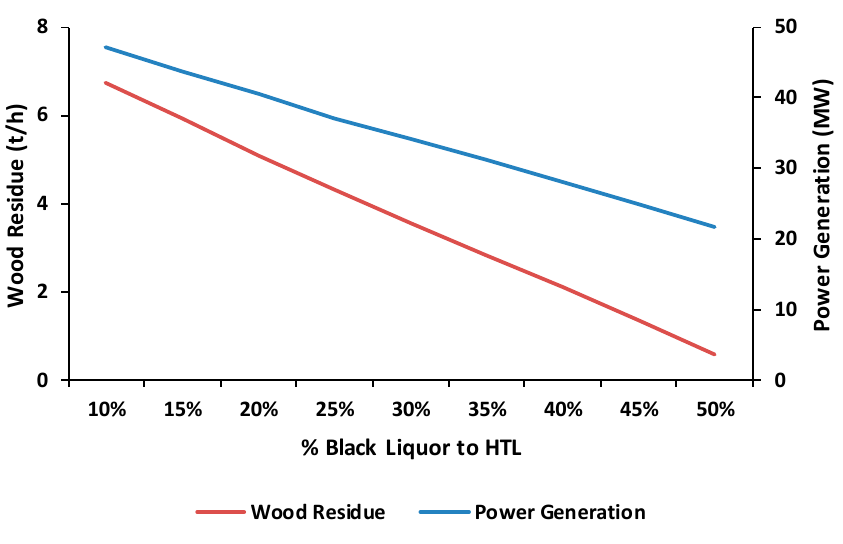
Figure 11. Effect of black liquor solids in HTL.